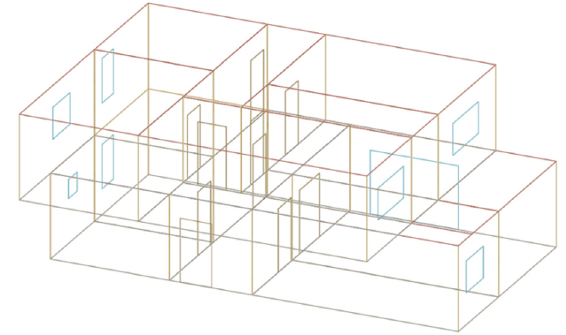
Figure 3. Simulated two-storey building model comprising of wall, door and window surfaces.